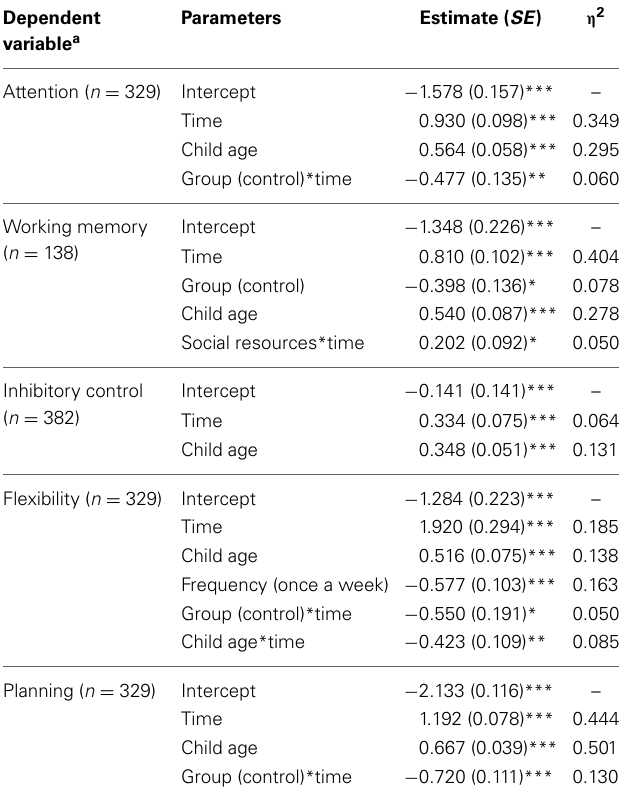
Table 8 | Results for the final model for each cognitive process in the